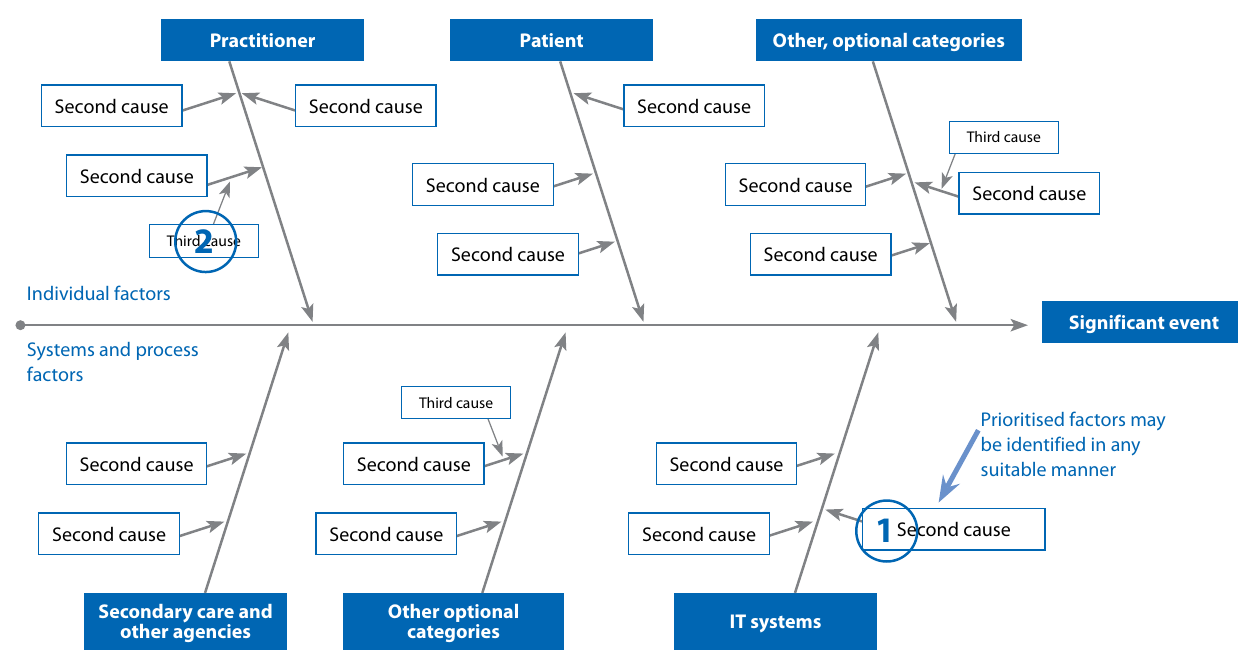
IT: information technology Figure 1: Approach to analysing the fishbone